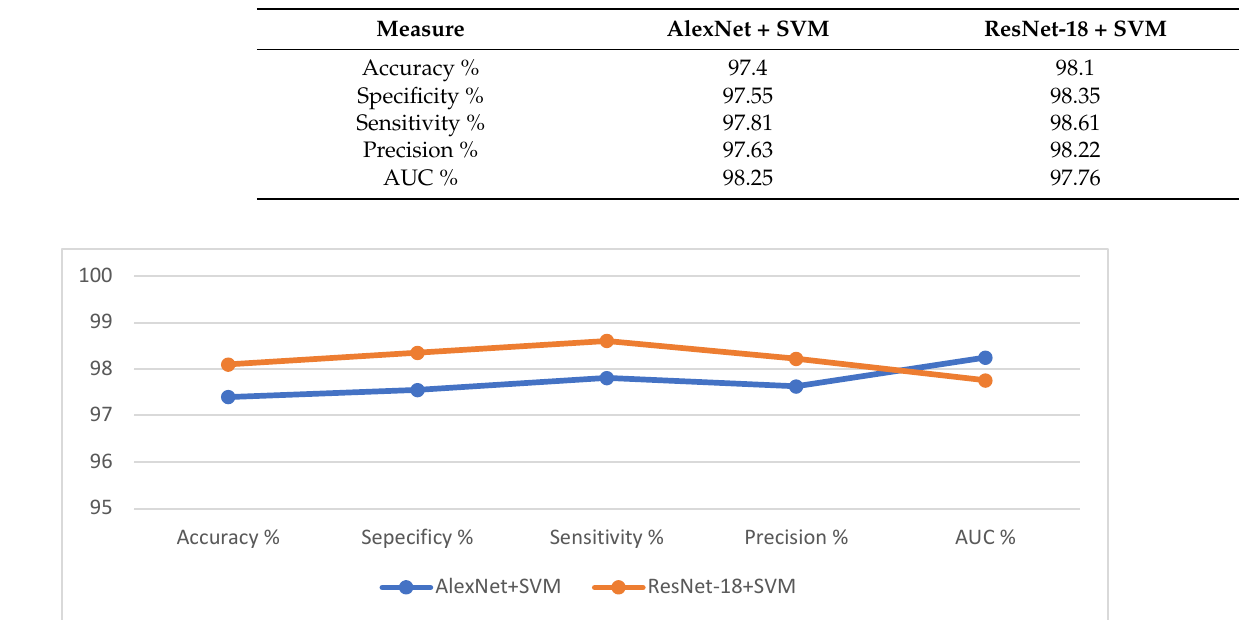
Figure 6. Evaluation of histopathological images for the diagnosis of OSCC.